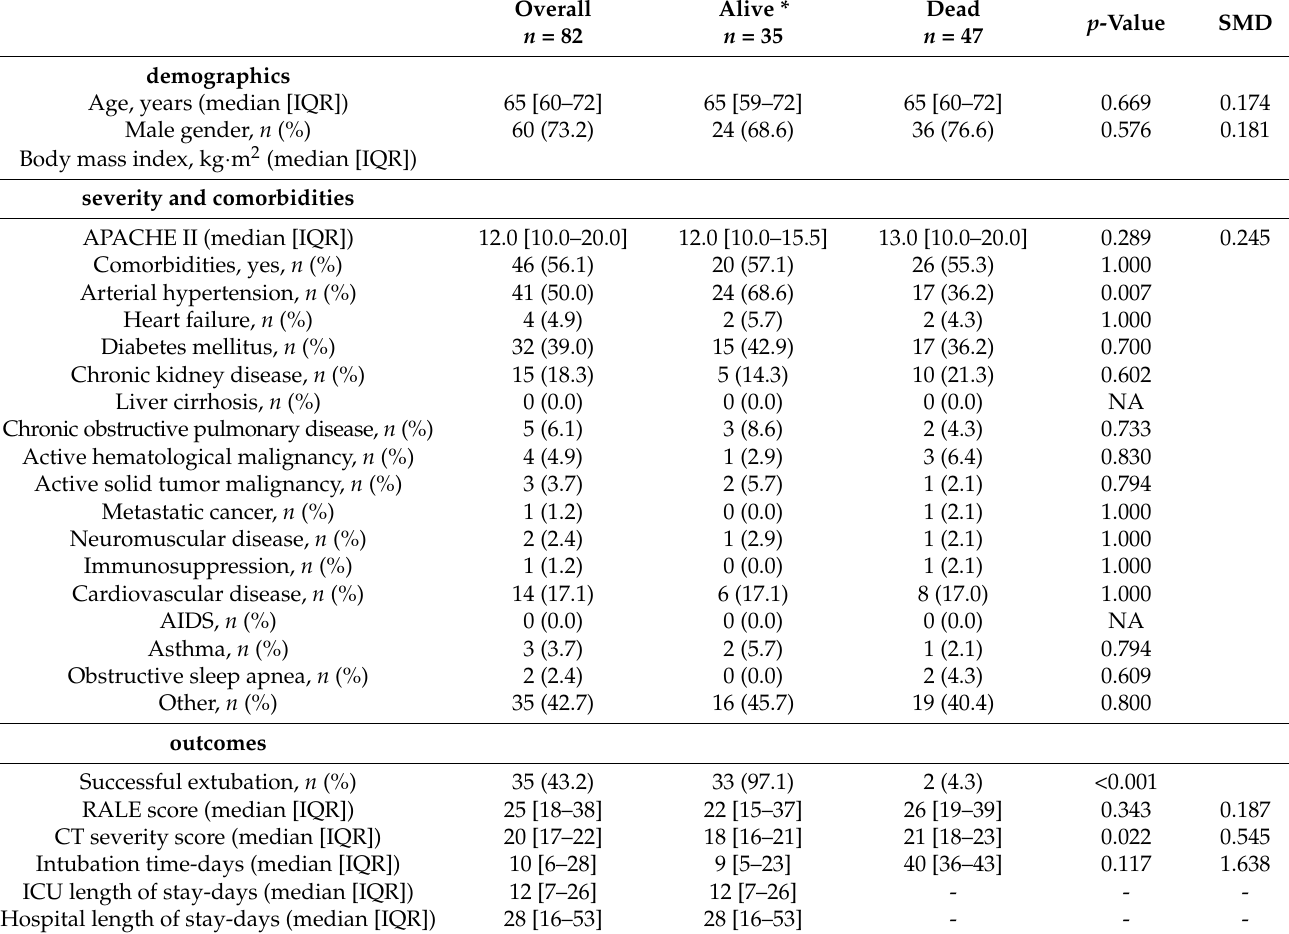
Table 1. Baseline characteristics of the patients.